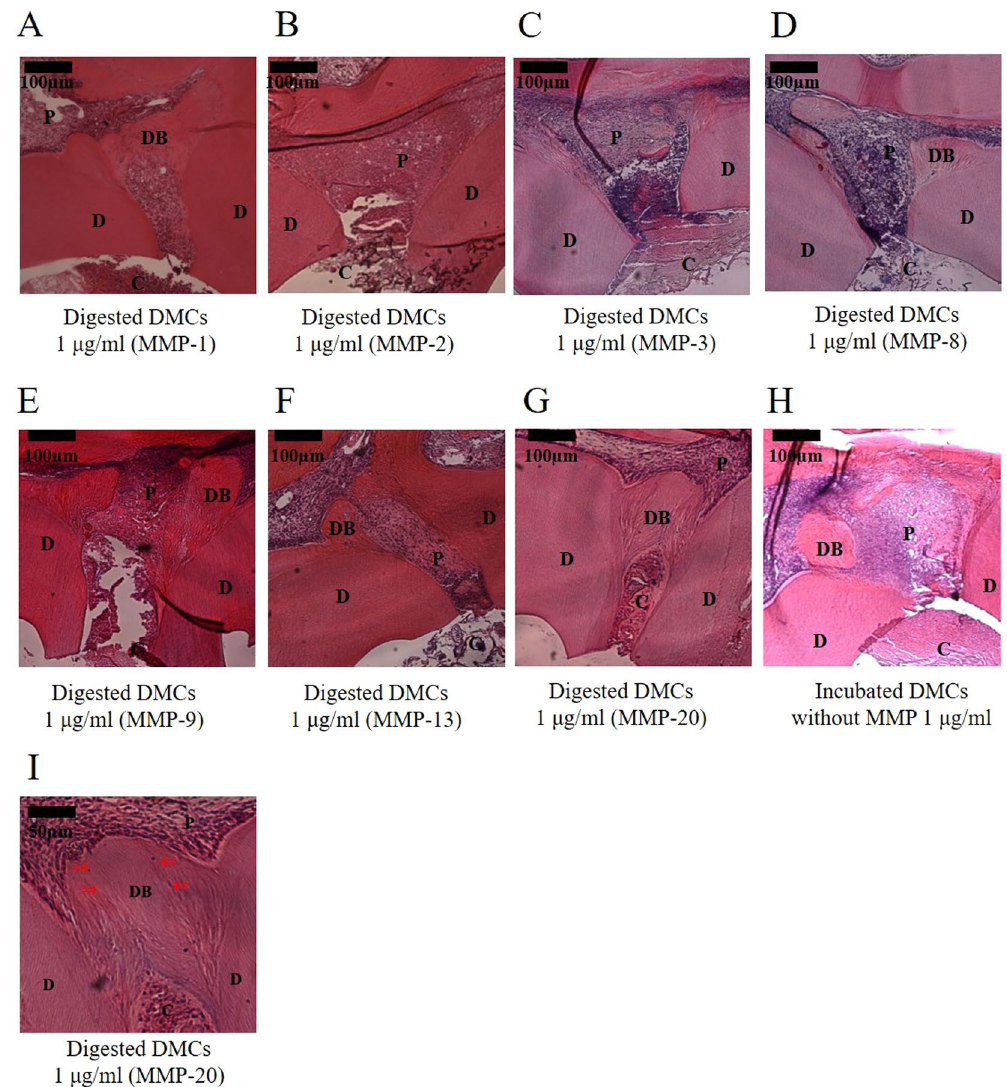
Figure 8. Histological images (100 × ) of tertiary dentin formation 28 days after direct pulp capping using 1 µ g/ ml of dentin matrix components (DMCs) treated with matrix metalloproteinase (MMP)-1 ( A ), MMP-2 ( B ), MMP-3 ( C ), MMP-8 ( D ), MMP-9 ( E ), MMP-13 ( F ), MMP-20 ( G ), or incubated DMCs without MMP ( H ). Higher magnification image (200 × ) of 1 µ g/ml of DMCs digested with MMP-20 ( I ). 1 µ g/ml of DMCs treated with MMP-1, -9, -13, or -20 facilitated hard tissue repair, compared with 1 µ g/ml of DMCs treated with other MMPs or incubated DMCs without MMP, based on the rate of coverage of the exposed pulp by tertiary dentin (p < 0.05) (see online Supplementary Tables 1 and 2). In particular, 1 µ g/ml of DMCs treated with MMP-20 induced a significantly higher condense and more regular tubular structure. Significant differences were not observed with lower concentrations (0.01–0.1 µ g/ml) of the above-described MMPs. These data represent six independent experiments. Arrows indicate dentinal tubules. C = cavity, D = dentin, DB = Tertiary dentin bridge, P =